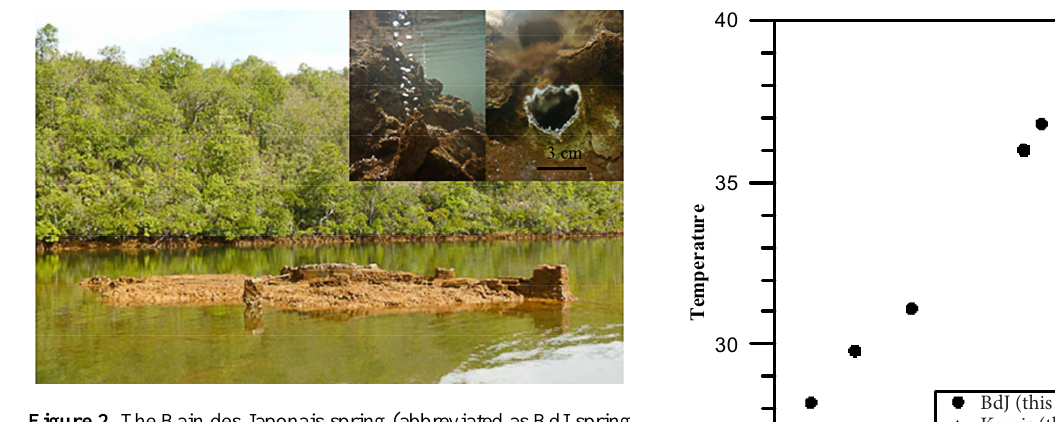
Figure 2. The Bain des Japonais spring (abbreviated as BdJ spring in the text). The carbonate platform is uncovered at low tide. It is surrounded by several underwater vents discharging high-pH waters and gas bubbles. Note the brick walls built by the convicts of the Prony penitentiary in the nineteenth century.